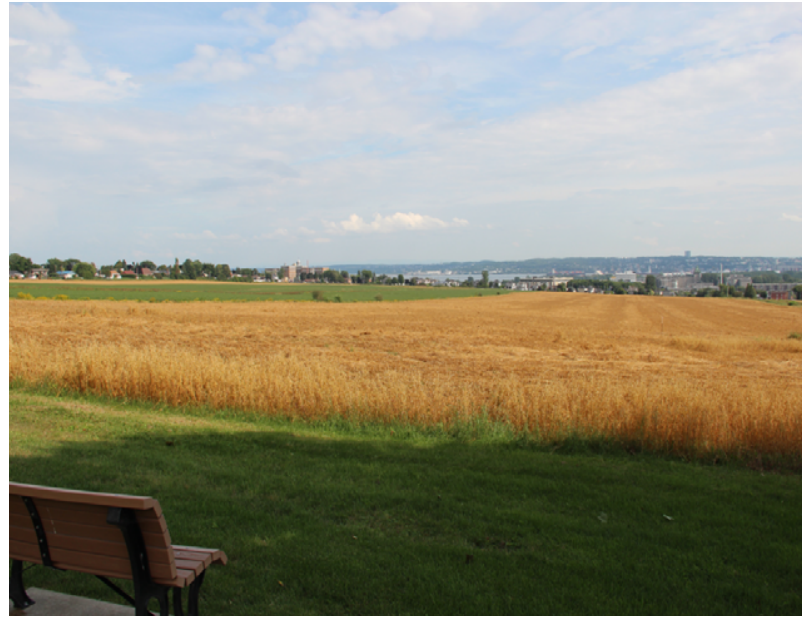
Jakob, F. (2022). Panorama from the car park on the south side of the Generalate of the Sisters of Charity in Quebec City. Bruxelles,